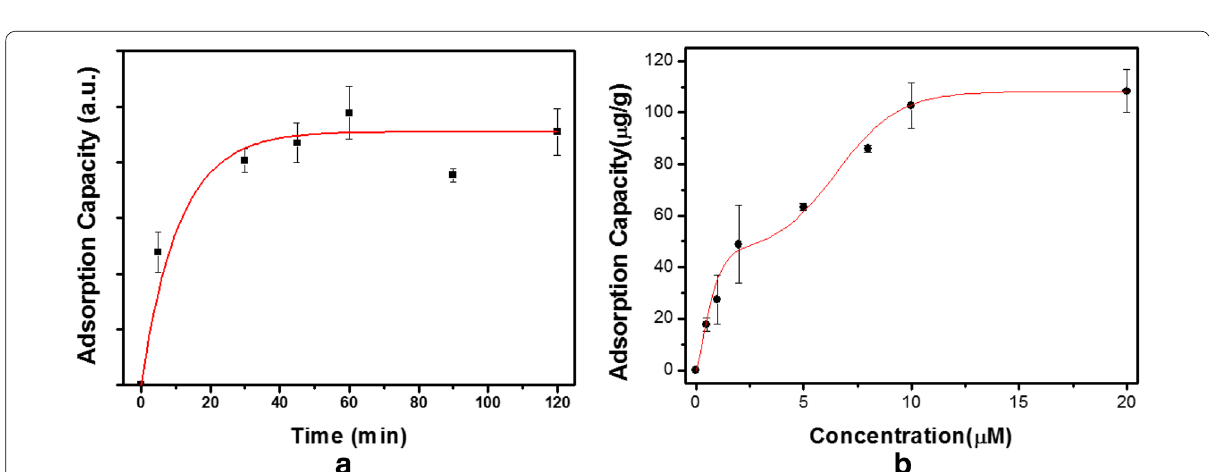
Fig. 5 a Adsorption kinetics of dopamine using 3‑aminophenylboronic acid‑functionalized magnetic silica (Fe 3 O 4 @SiO 2 @APBA) at pH 8.5. b Adsorption isotherms of Fe 3 O 4 @SiO 2 @APBA for dopamine at pH